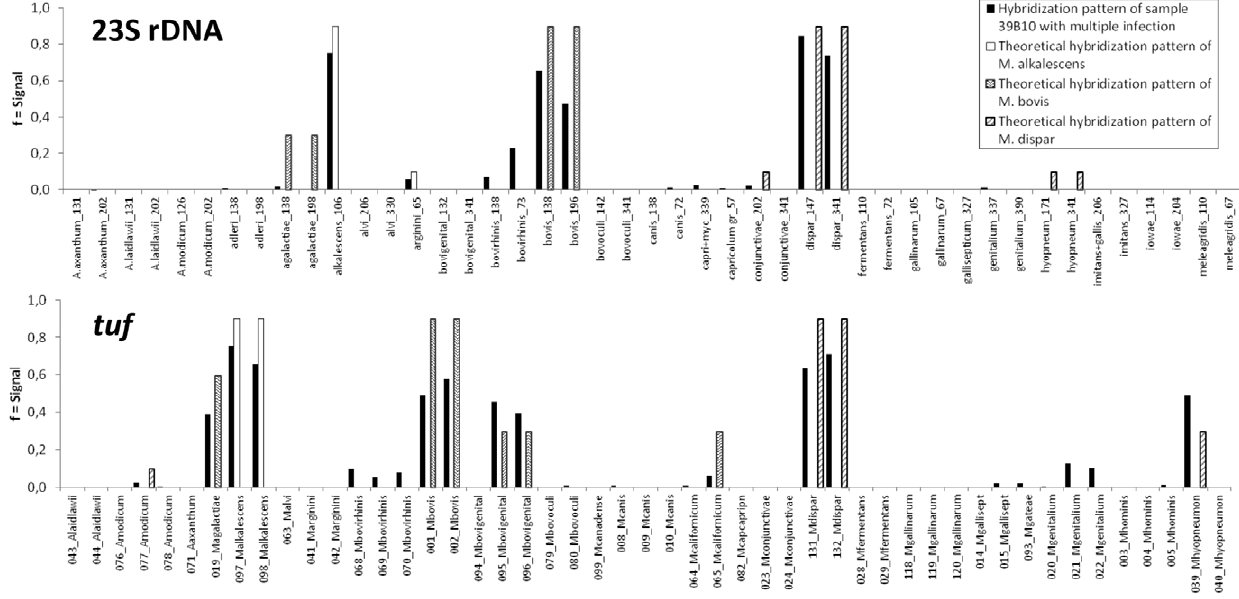
Figure 4. Detection of multiple mycoplasma infection in a DNA extract from bovine lung tissue (sample 39 B 10, Table 2). The diagram shows the combined pattern match of sample and three matching Mycoplasma spp. Black bars denote the hybridization signals of the sample, while theoretically predicted signals for M. alkalescens , M. bovis and M. dispar are represented by empty, dashed and dotted bars, respectively. This close-up presentation shows only the relevant sections of the diagram.